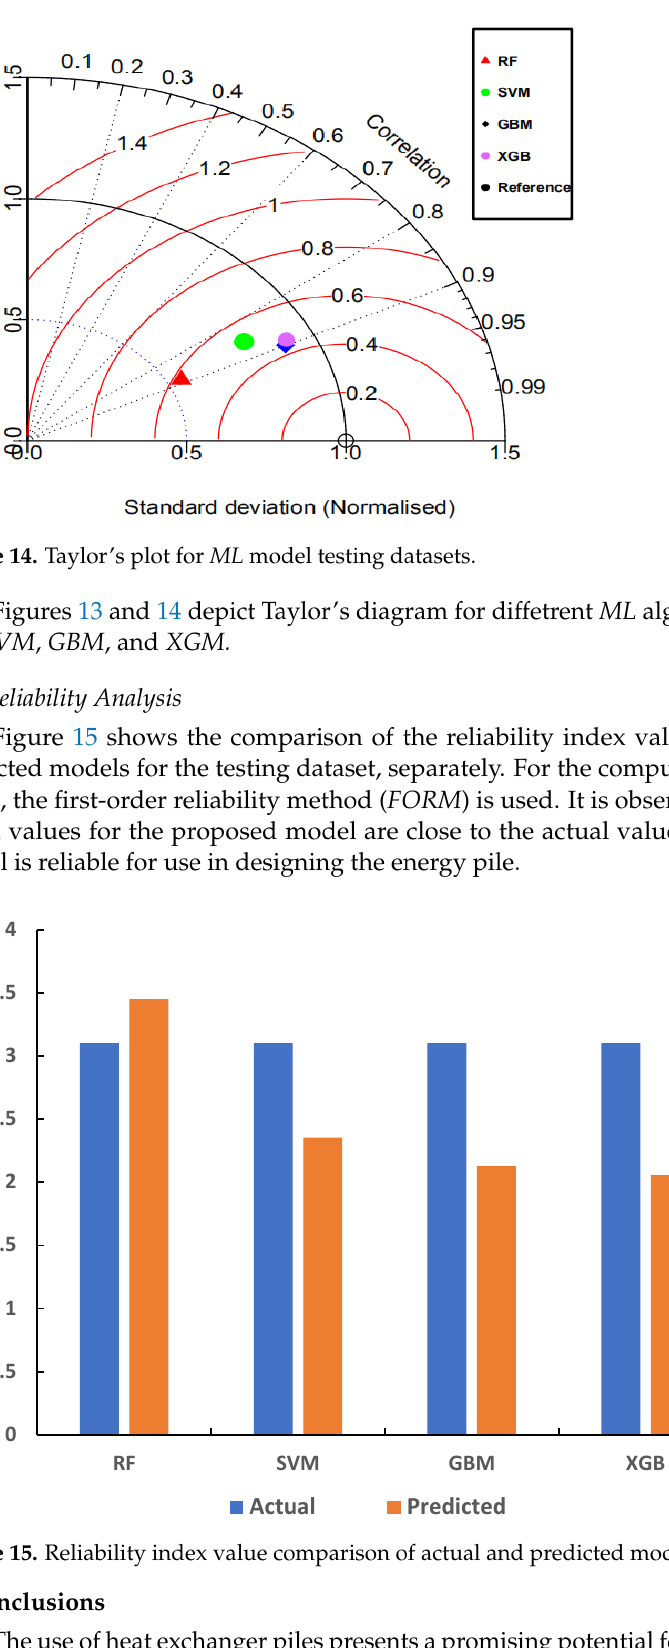
Figure 13. Taylor’s plot for ML model training datasets.